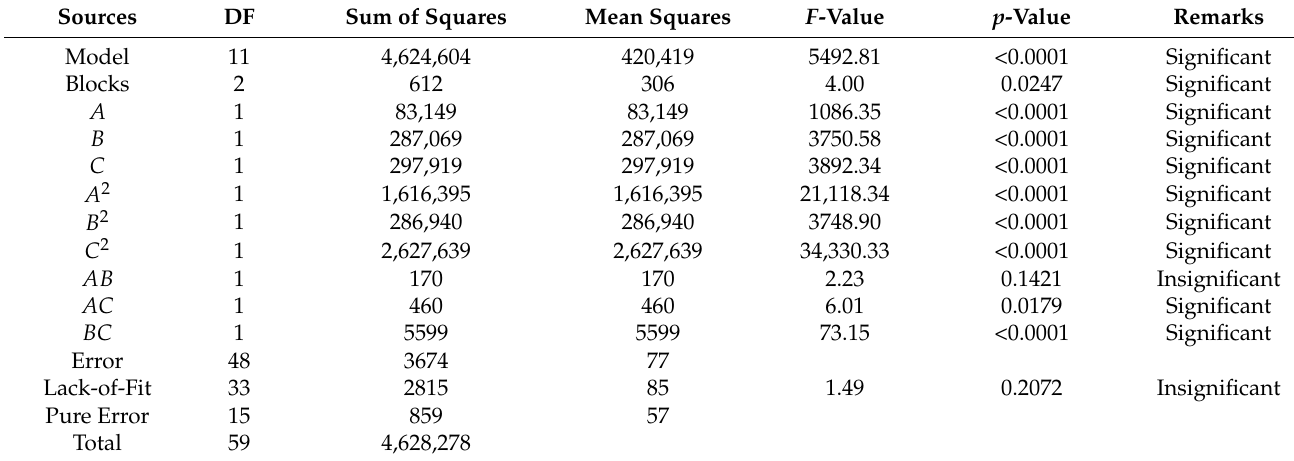
Table 2. ANOVA for the synthesis of HKUST-1 using three independent parameters designed with CCD of RSM. Sources Sum of